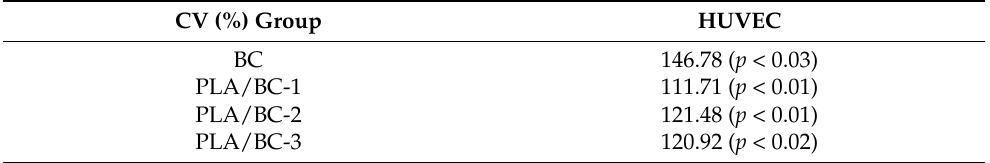
Table 2. Cell viability of HUVEC on BC membrane and PLA/BC composite scaffolds. CV (%)